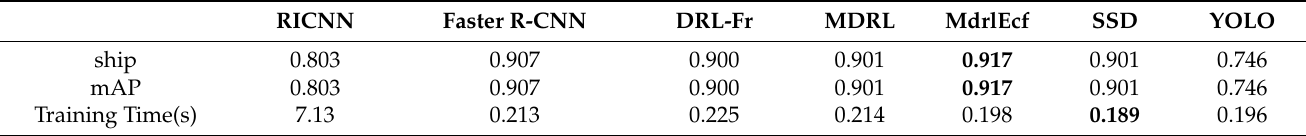
Table 4. Comparison of detection accuracy of different models on the SAR-Ship-Dataset dataset.